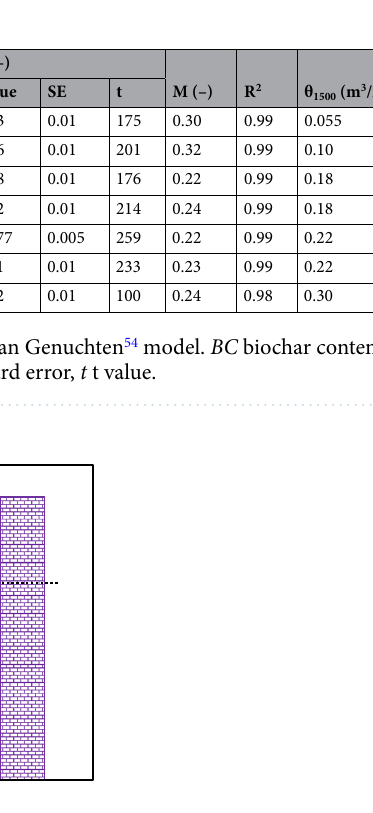
Figure 5. SWRCs of different biochar-amended vegetated soil.